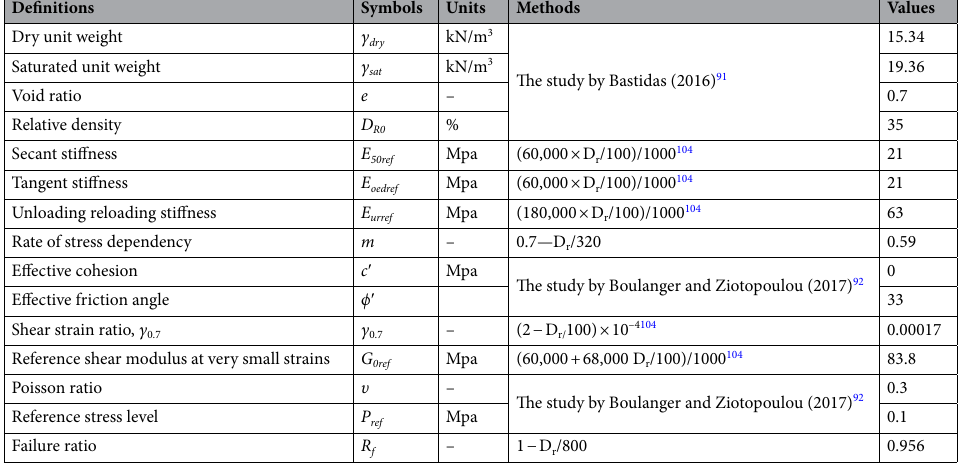
Table 7. HSS Parameters Ottawa sand with a relative density of